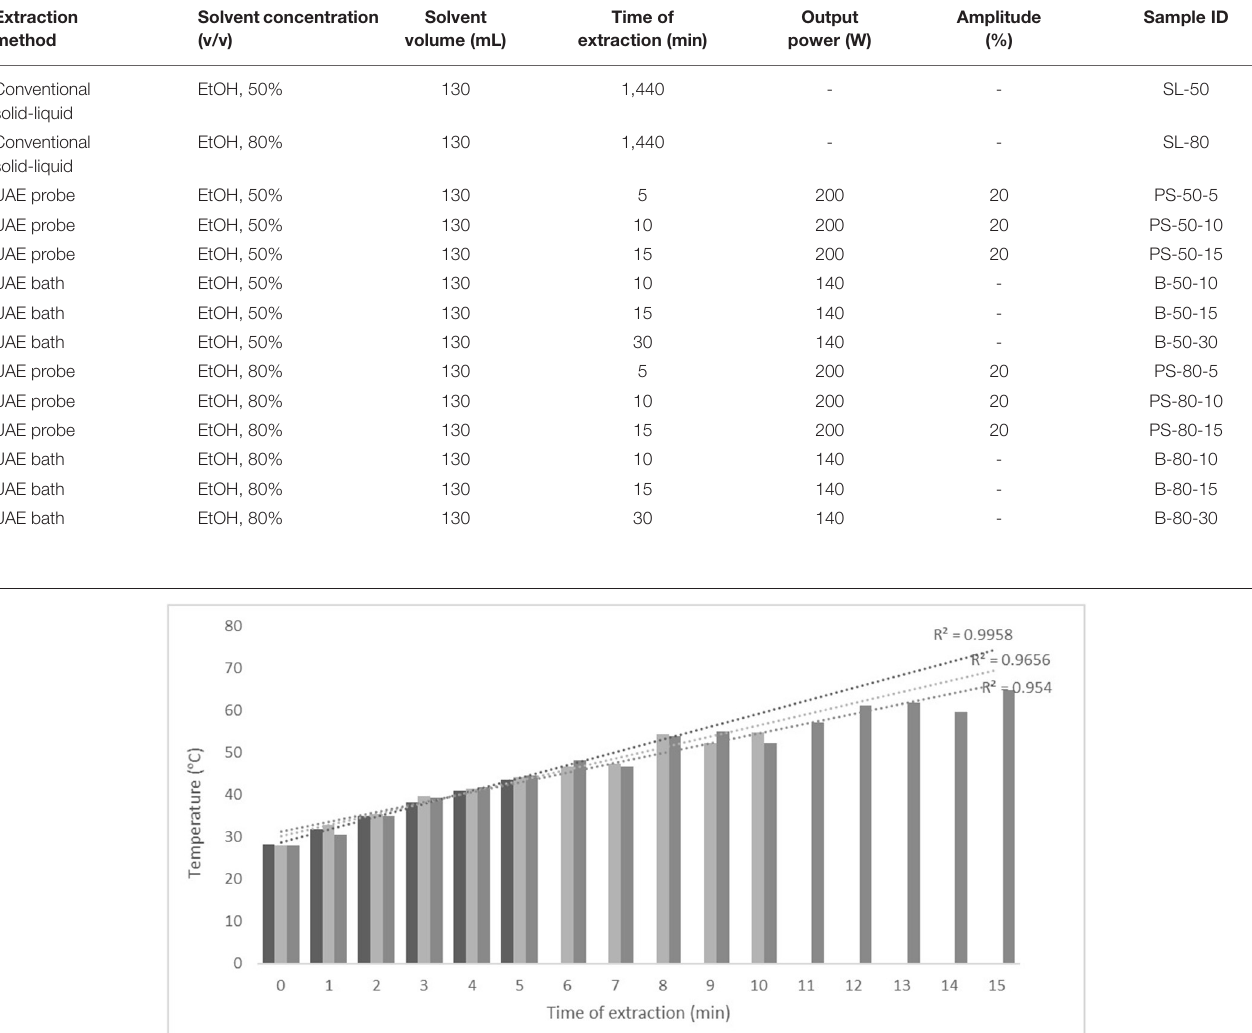
TABLE 1 | Nettle powder extraction experiment